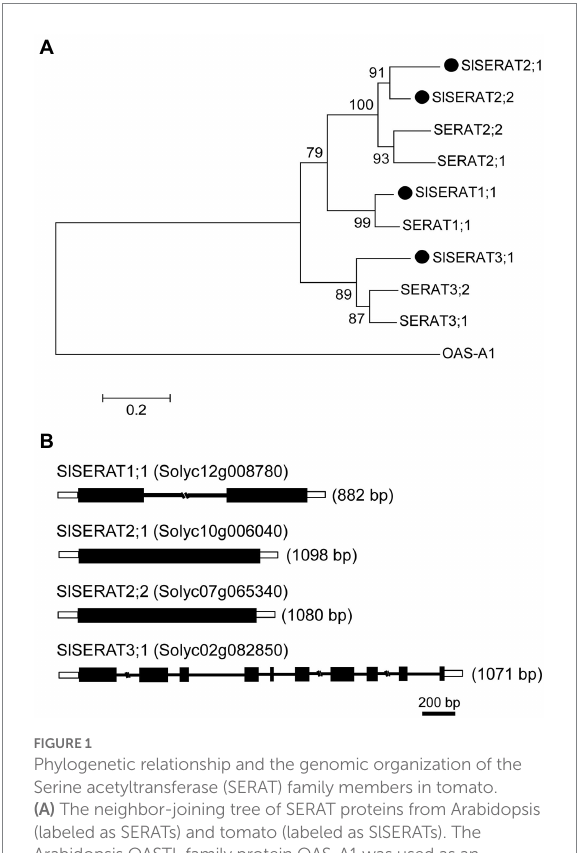
FIGURE 1 Phylogenetic relationship and the genomic organization of the Serine acetyltransferase (SERAT) family members in tomato. (A) The neighbor-joining tree of SERAT proteins from Arabidopsis (labeled as SERATs) and tomato (labeled as SlSERATs). The Arabidopsis OASTL family protein OAS-A1 was used as an outgroup control. (B) Gene structures of the tomato SERATs (SlSERATs). The numbers in brackets represent the lengths of the CDSs of the